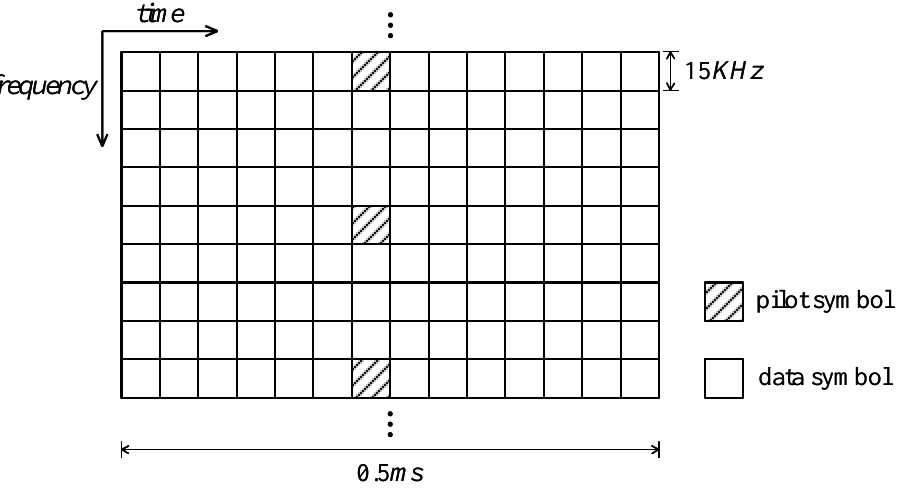
Figure 4. Frame structure adopted in